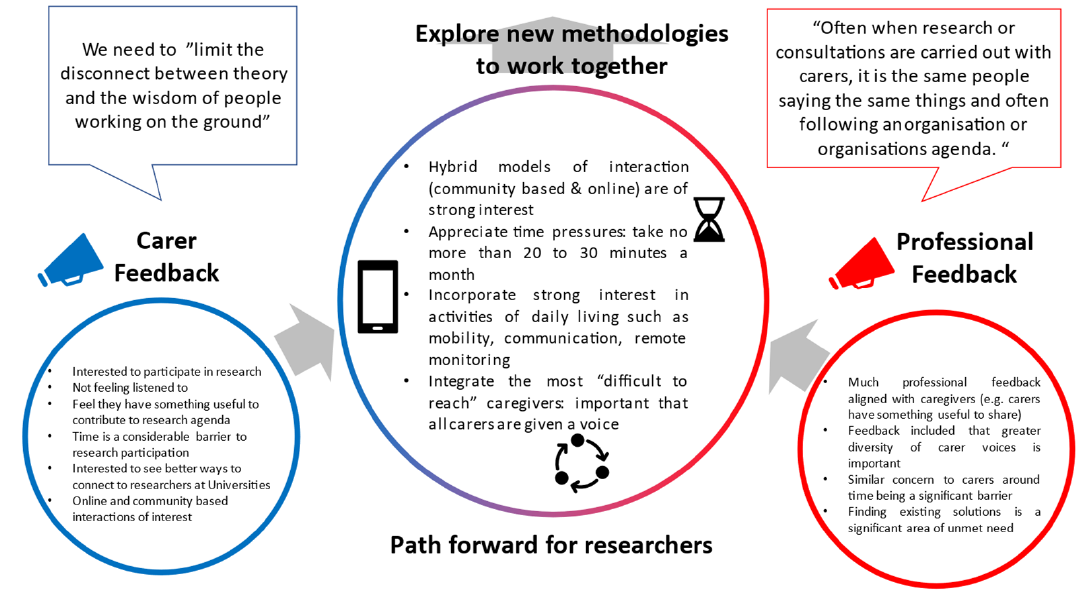
Figure 5. Summary figure summating both informal caregiver and professionals/innovators inter- Figure 5. ested in the caregiver demographic.